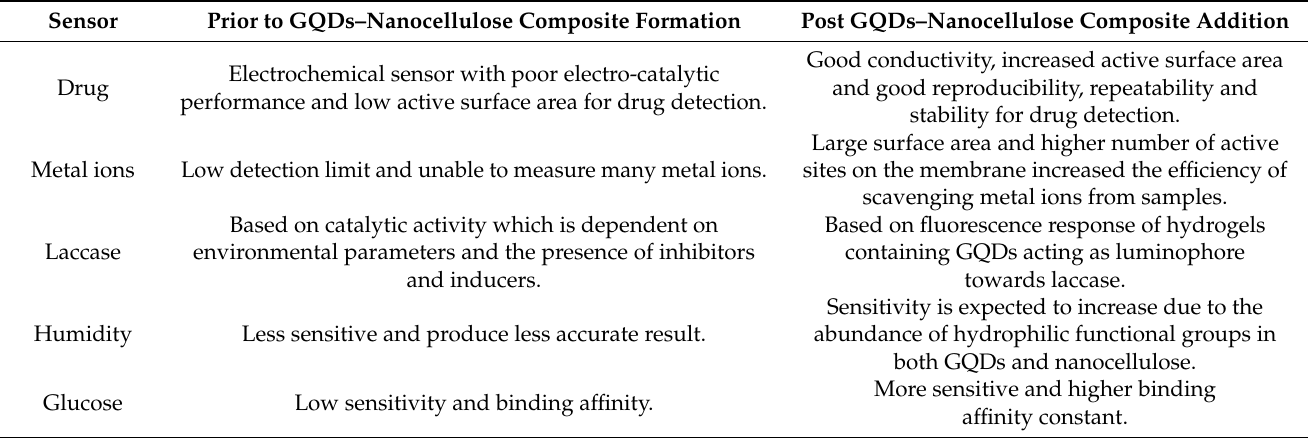
Table 2. A summary of various GQDs–nanocellulose composite-based platforms used for sensing applications.